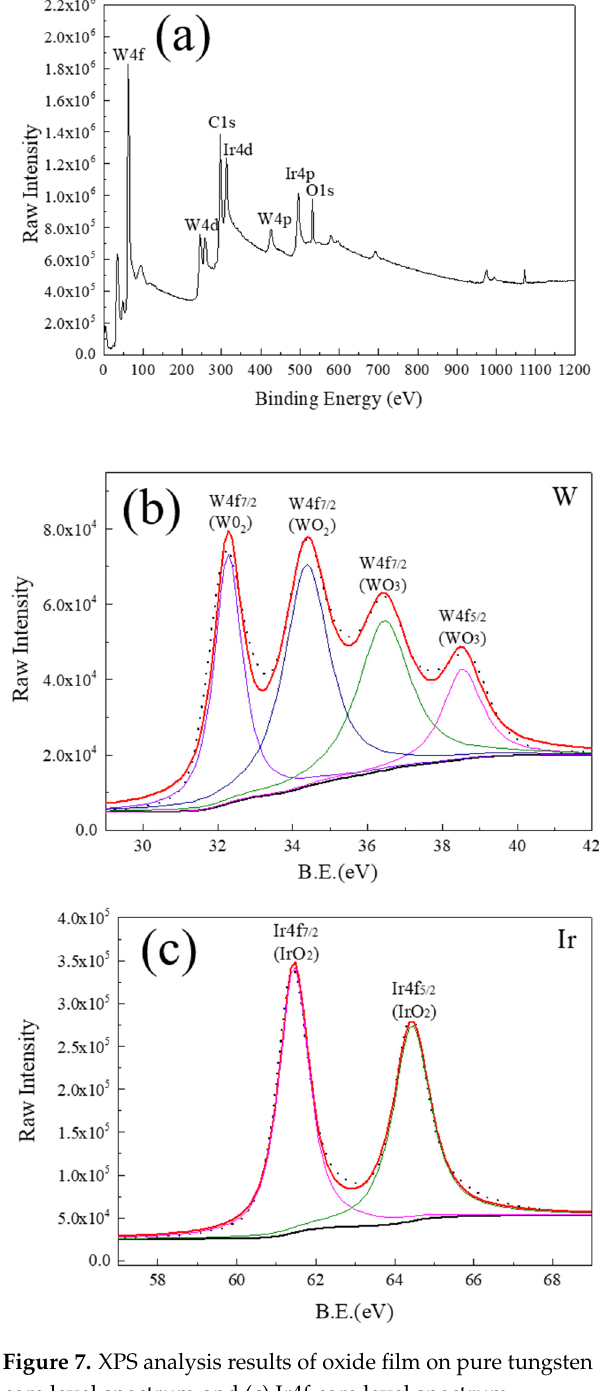
Figure 7. XPS analysis results of oxide film on pure tungsten specimen: ( a ) Survey spectrum, ( b ) W4f core level spectrum and ( c ) Ir4f core level spectrum.